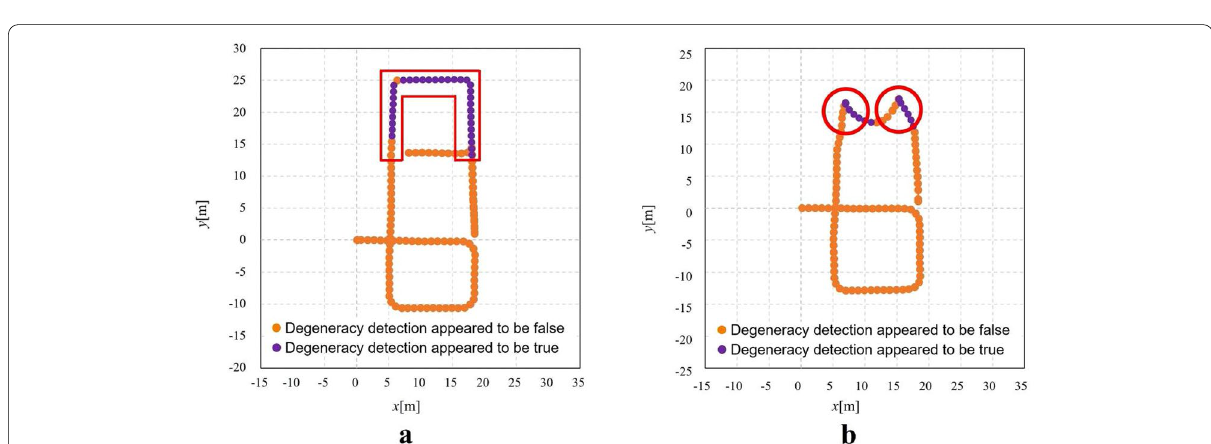
Fig. 12 Result of degeneracy detection at each location a Result in the environment for dealing with degeneracy in the direction of translation, b Result in the environment for dealing with degeneracy in the direction of